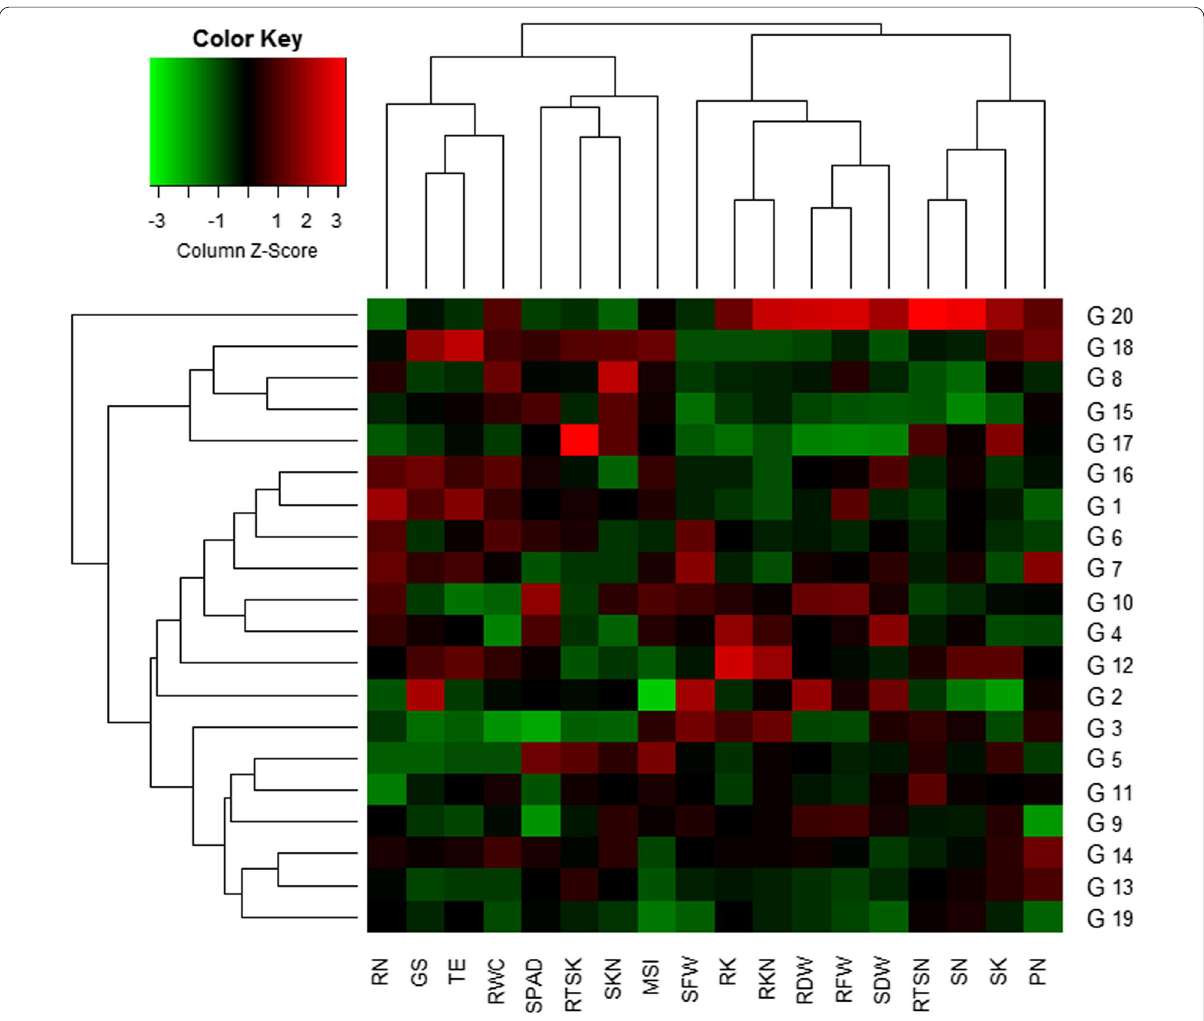
Fig. 2 Graphical display of the relationships among the 20 investigated barley genotypes and 18 measured growth and physiological traits under salinity stress conditions. The different colors and intensities were adjusted based on associations among genotypes and traits. Colors are representative of a relative scale ( 3 to 3) derived after data standardization. The darker green indicates lower values, while the darker − + red indicates higher values. RFW, root fresh weight; SFW, shoot fresh weight; SDW, shoot dry weight; SPAD, relative chlorophyll content; P N , photosynthetic rate; G S , stomatal conductance; T E , transpiration rate; MSI, membrane stability index; RWC, relative water content; RN, root Na + content; RK, root K + content; SN, shoot Na + content; SK, shoot K + content; RKN, root K + :Na + ratio; SKN, shoot K + :Na + ratio; RTSN, root‑to‑shoot Na + translocation; RTKN, root‑to‑shoot K +